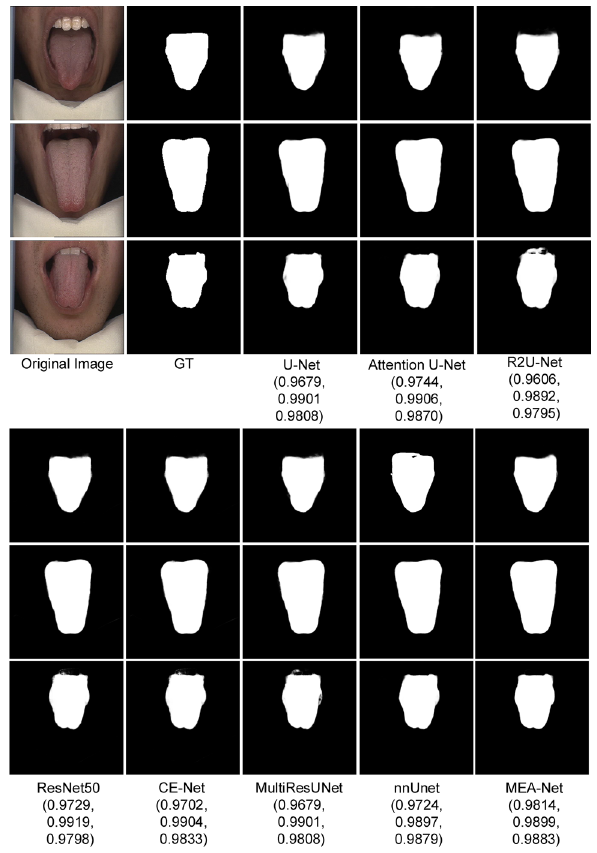
Figure 6. Sample results of tongue image segmentation. (The Dice values for each legend are in